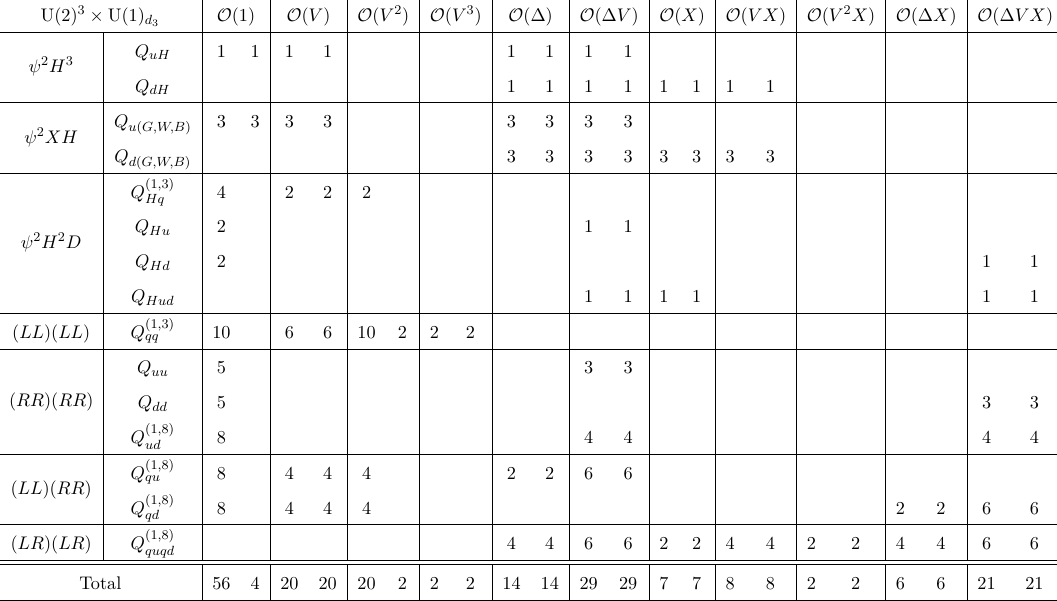
Table 4 . Counting of the pure quark SMEFT operators (see appendix A) assuming U(2) 3 × U(1) d symmetry in the quark sector. The counting is done up to three insertions of the V q spurion and one insertion of ∆ u,d or X b . For spurion products, the counting is presented for ∆ u,d V q , V q X b , and ∆ u,d X b as well as for V 2 X b and ∆ u,d V q X b insertions. The left (right) entry in each column gives q the number of CP even (odd) coefficients at the given order in spurion